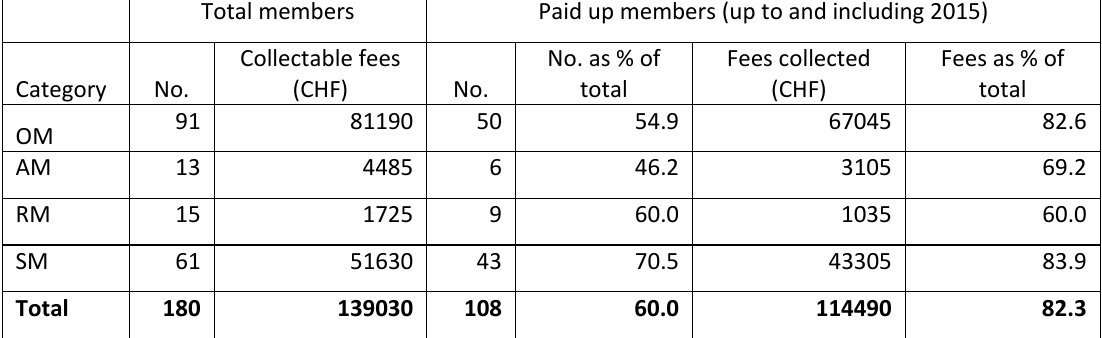
Table 3: Summary of ISPRS members and status by category (report dated 19 April